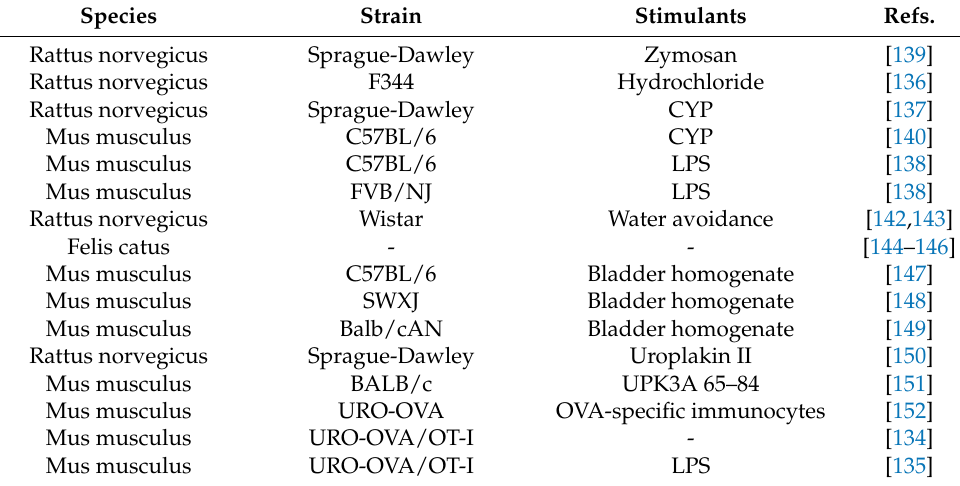
Table 3. Animal models of IC/BPS in recent studies. Species Strain Stimulants